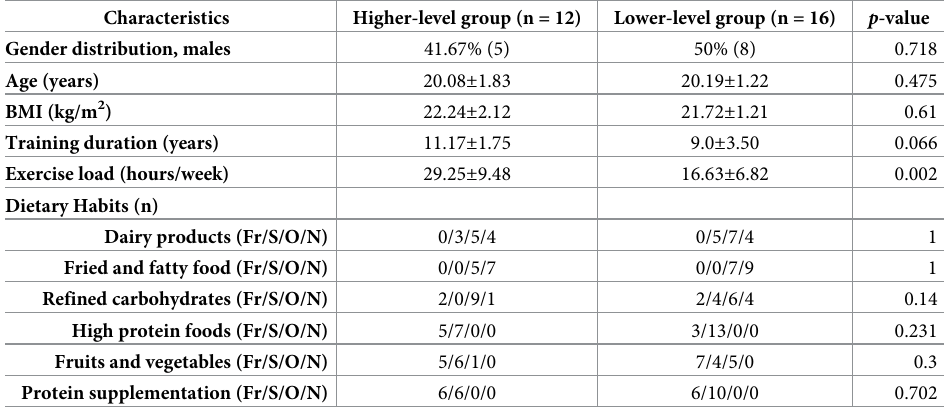
Table 1. The characteristics of the enrolled athletes. Characteristics Higher-level group (n =